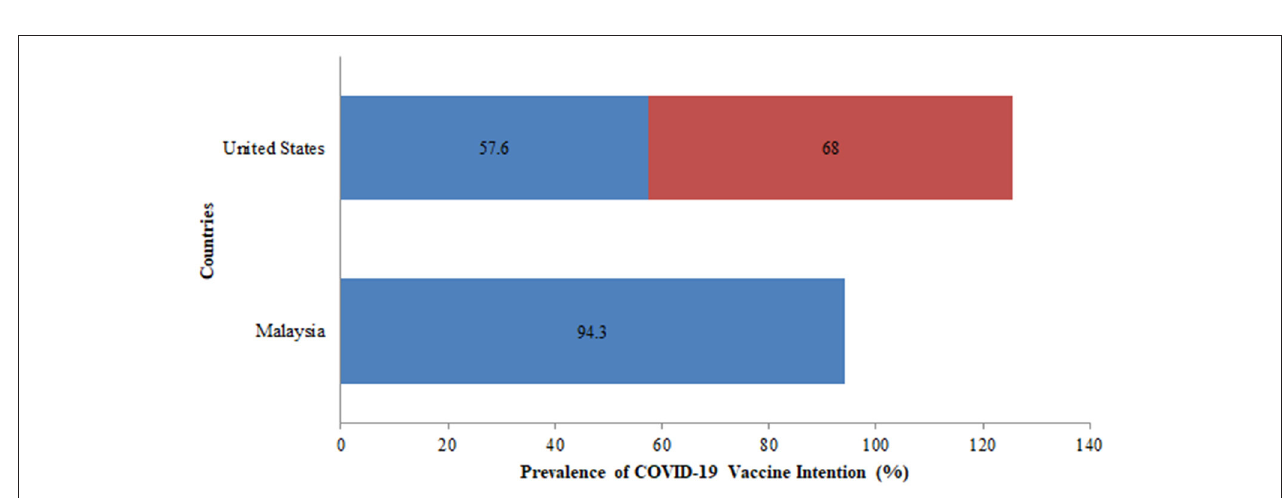
FIGURE 6 | Prevalence of COVID-19 vaccine intention across various countries among the general population.